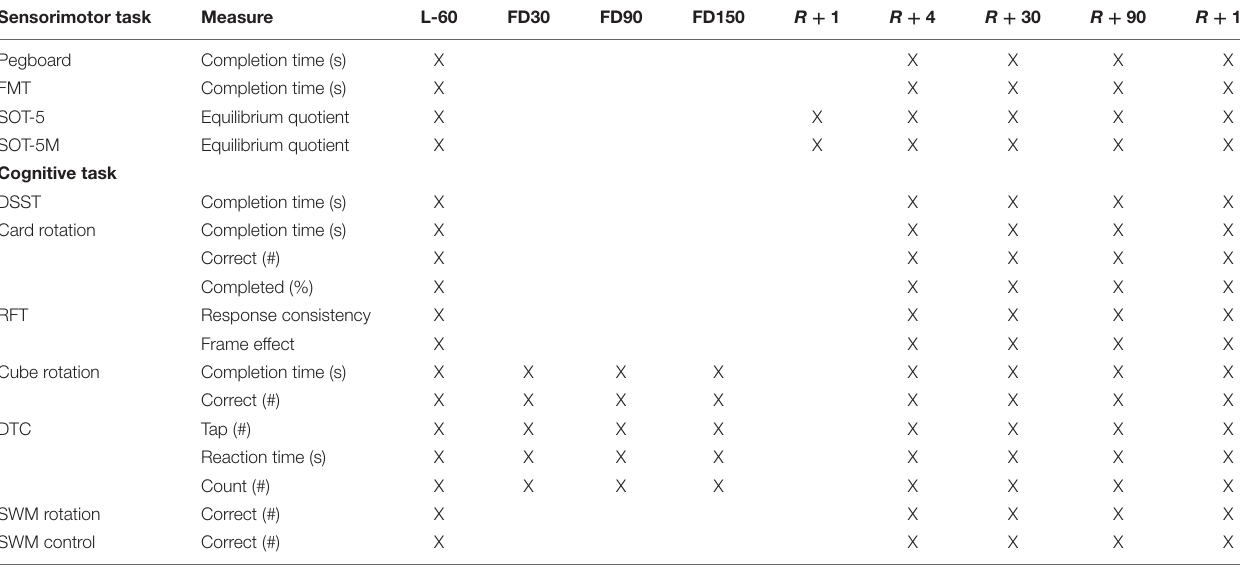
TABLE 2 | Tasks and data collection time points. Sensorimotor task